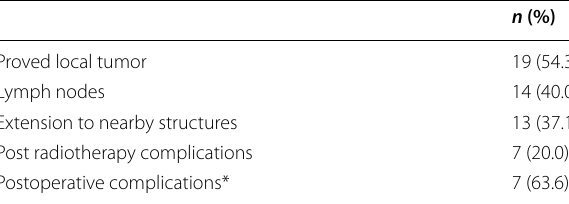
*Percentage was calculated based on total 11 patients underwent surgery